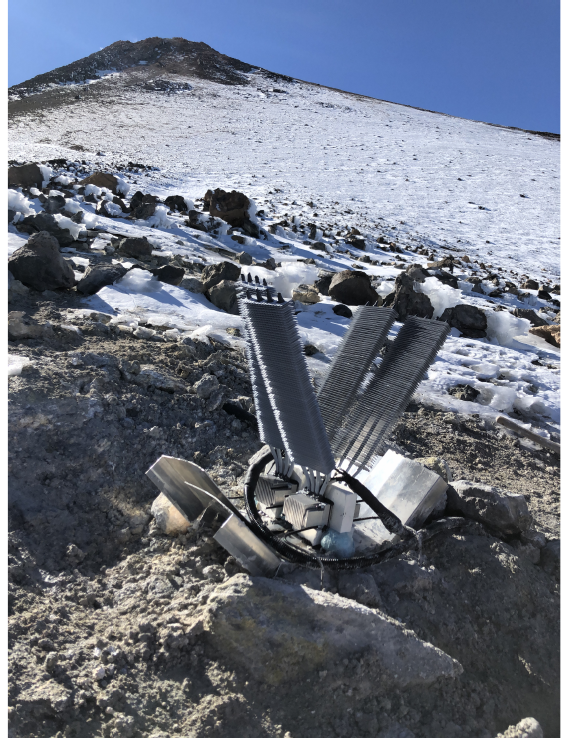
Figure 9. Prototype installed at Teide volcano on December 2019, composed of 4 thermoelectric